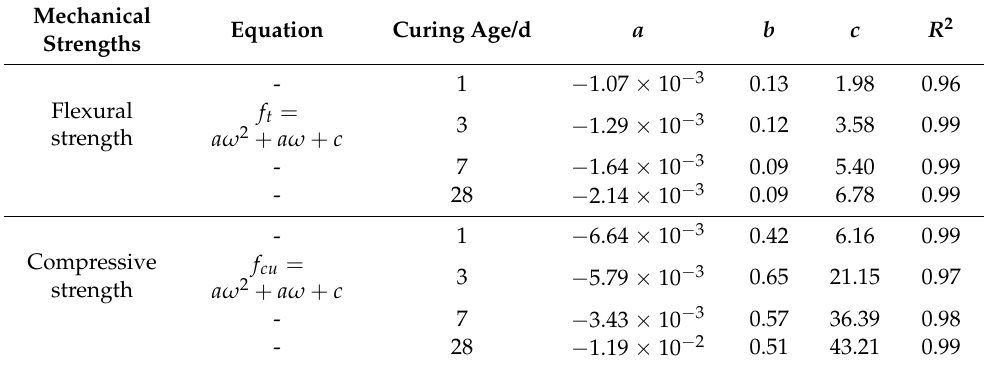
Table 5. The fitting results of mechanical strength and mass ratio ( ω ) of WFA. Mechanical Equation Strengths Flexural strength